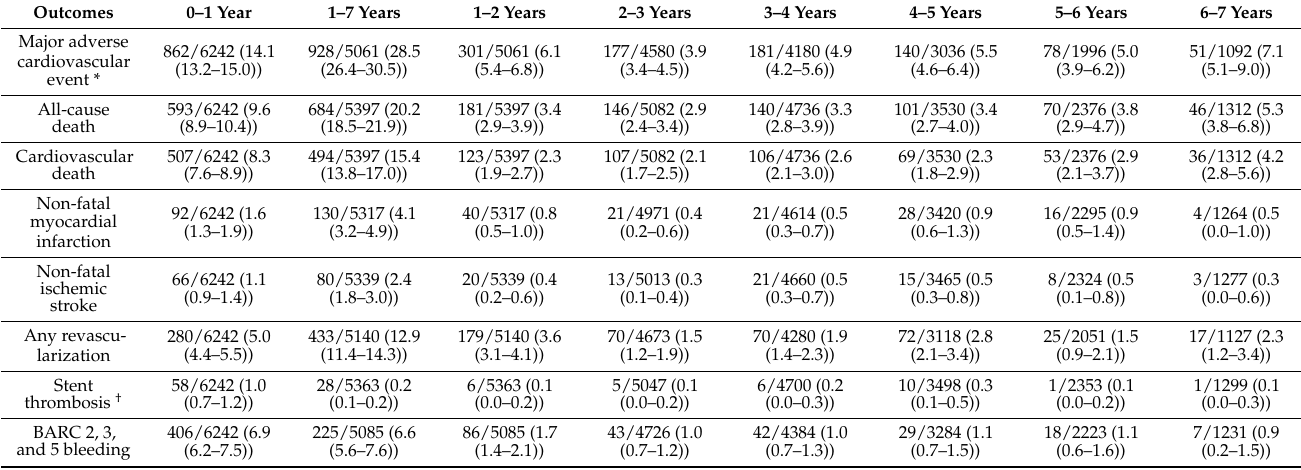
Table 2. Clinical outcomes according to time periods after percutaneous coronary intervention.